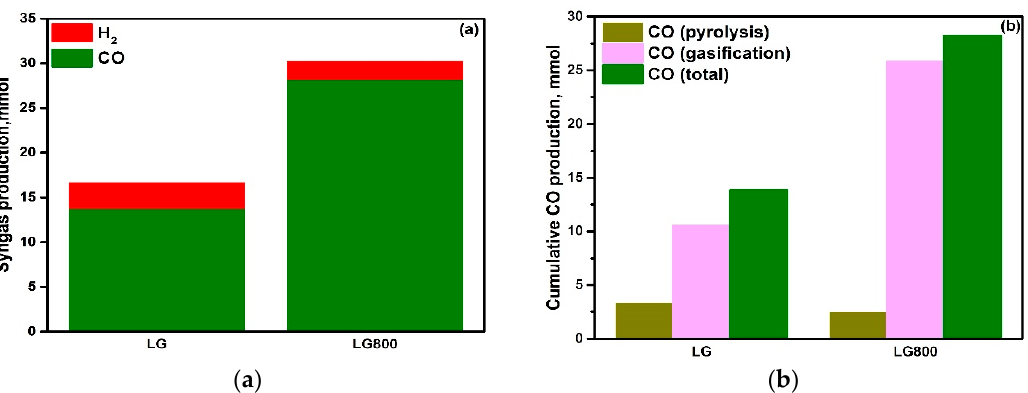
Figure 12. Syngas production ( a ), and shares of pyrolysis and gasification steps to the overall CO production for LG and LG800 ( b ) during isothermal CO 2 gasification tests at 800 ◦ C. Fuel: 500 mg, Flowrate: 30 cm 3 /min.